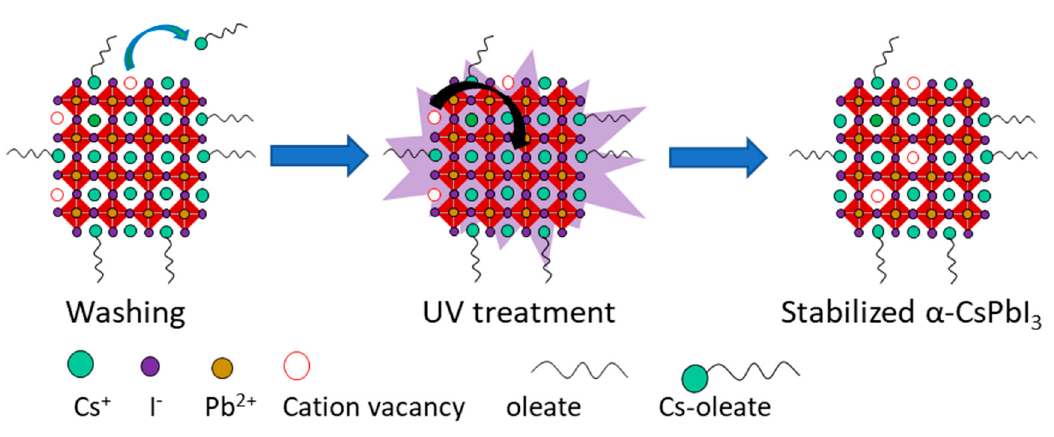
Figure S1: Top view SEM image of the CsPbI 3 QDs 3 layer film with higher magnification, Figure S2: (a) Photograph of accidental detachment of photoactive layer after EtOAc washing in a device with 1 min UV treatment. (b) Pictures of the solar cells after air exposure, left EtOAc and right UV treated device, Table S1: Photovoltaic parameters extracted from J–Vs scans, best device of each variation, Table S2: Time resolved PL decay fitting parameters with a biexponential